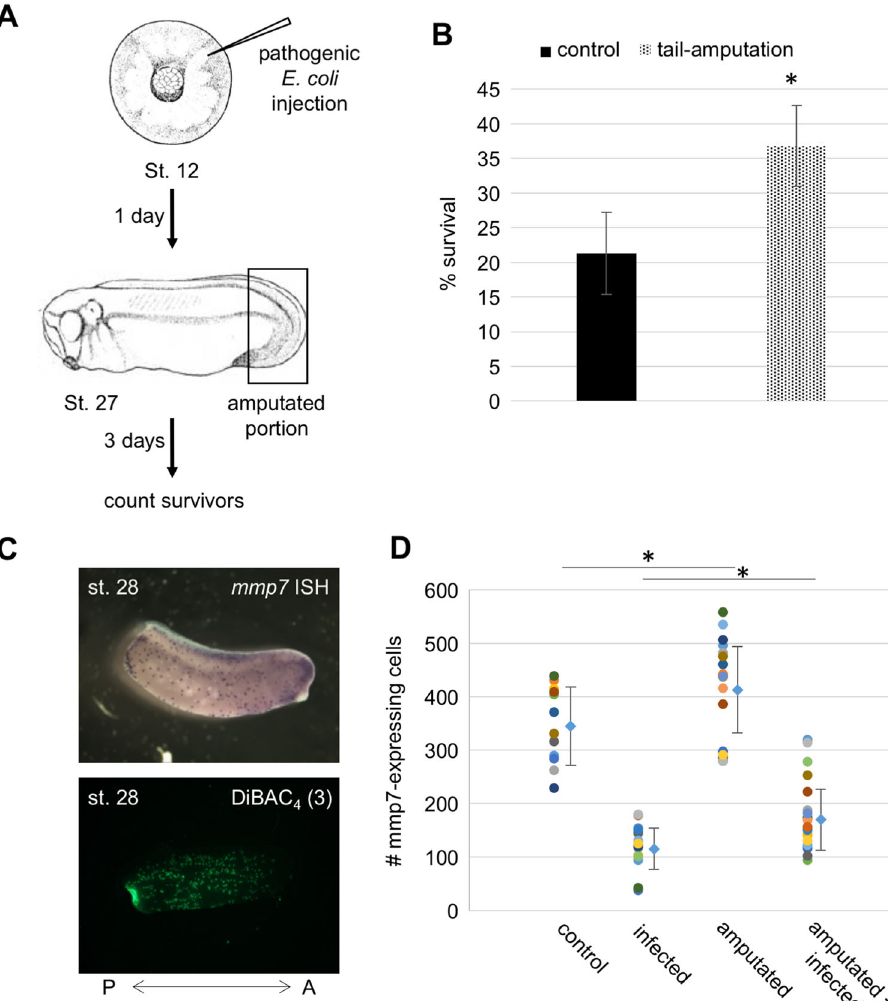
Fig. 6 Tail amputation increases resistance to infection. a Embryos at NF stage 12 (gastrula) were infected with uropathogenic E. coli and, after reaching NF stage 27 (post-hatching), were amputated from the posterior fi fth of the body. The number of survivors was quanti fi ed 3 days later (4 days post-infection) and compared with non-amputated infected embryos. b Comparison of survival to infection percentages between non-amputated ( plain column ) and amputated ( dotted column ) embryos reveals an augmentation of survival by tail amputation and subsequent regeneration. Each column represents three independent assays. c Visualization of mmp7 -expressing myeloid cells by in situ hybridization following amputation ( top panel ) reveals increased posterior concentration of primitive myeloid cells, and detection of depolarized cells by staining with DiBAC 4 (3) voltage dye ( lower panel ) reveals a cluster of highly depolarized cells at the posterior extremity of the embryo after tail amputation. d Quanti fi cation of mmp7 -expressing cells following infection and/or amputation at NF stage 28 reveals signi fi cant increases in mmp7 -expressing cells consequent to tail amputation. *denotes p <